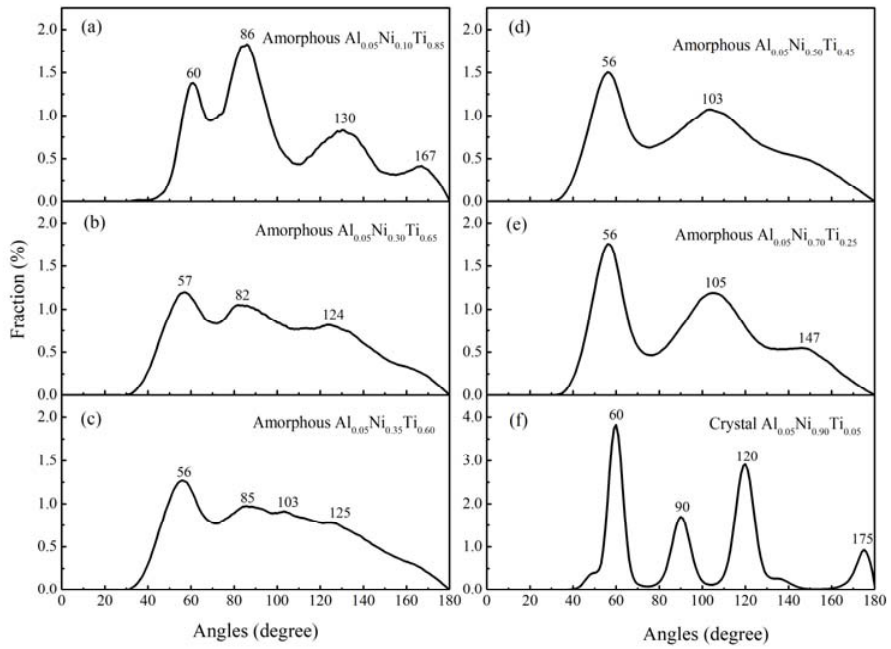
Figure 6. Total bond-angle distribution functions of alloys: ( a ) amorphous Al 0.05 Ni 0.10 Ti 0.85 , ( b ) amorphous Al 0.05 Ni 0.30 Ti 0.65 , ( c ) amorphous Al 0.05 Ni 0.35 Ti 0.60 , ( d ) amorphous Al 0.05 Ni 0.50 Ti 0.45 , ( e ) amorphous Al 0.05 Ni 0.70 Ti 0.25 , ( f ) crystal Al 0.05 Ni 0.90 Ti 0.05 .